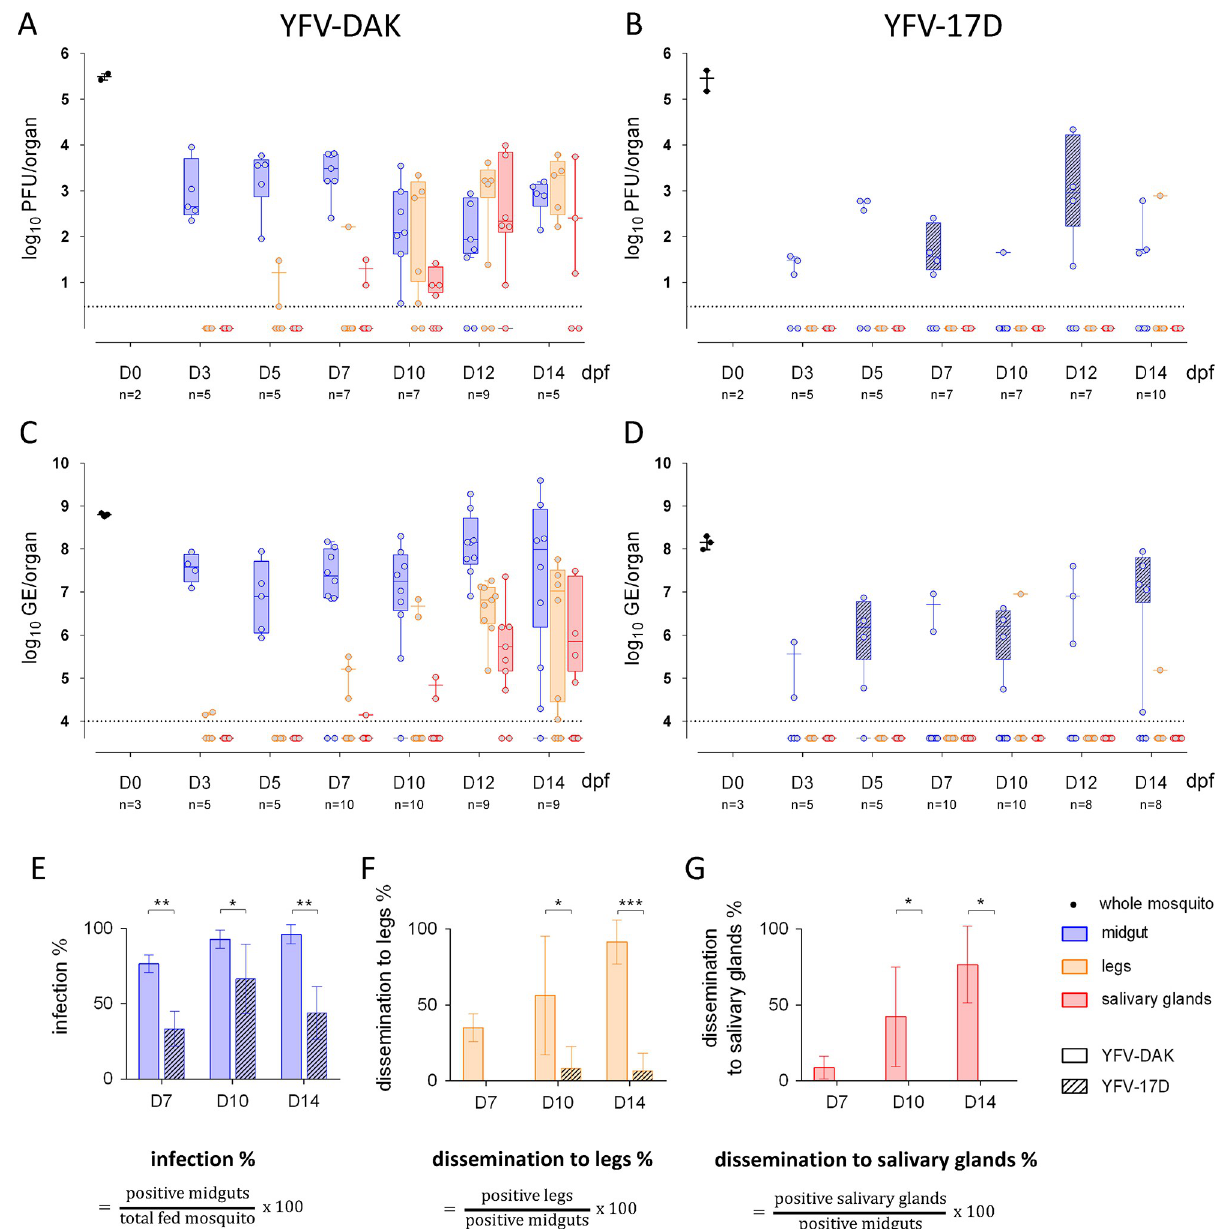
Fig 1. YFV-17D, but not YFV-DAK, fails to overcome the midgut barriers of Aedes aegypti . Mosquitoes were orally infected with 4.10 7 PFU/mL of YFV-DAK (A and C) or YFV-17D (B and D). (A and B) The presence of infectious viruses in individual midgut, legs and salivary glands was assessed by plaque assay on Vero cells at 3, 5, 7, 10, 12 and 14 day post feeding (dpf). Several whole mosquitoes were also analyzed 20 minutes after feeding (black dots). Each data point represents the YFV titers of a single organ. (C, D) The relative amounts of organ-associated viral RNA were determined by RT-qPCR analysis and are expressed as genome equivalents (GE) per organ at 3, 5, 7, 10, 12 and 14 dpf. Total RNA was also extracted from several whole mosquitoes the same day of the feeding (black dots). (A-D) The dashed lines indicate the limit of detection. One representative RT-qPCR experiments out of three independent ones is shown. The other two are shown in S1 Fig. YFV infection rates among midguts (E), YFV dissemination rate among legs (F) and YFV dissemination rate among salivary glands (G) were determined by RT-qPCR analysis at 7, 10 and 14 dpf. (E-G) Data were obtained from 3 independent experiments. Error bars indicate the means ± SD. Statistical analyses were performed using a two-tailed Fisher’s exact test ( � p < 0.05; �� p < 0.01; ��� p < 0.001; ���� p < 0.0001).